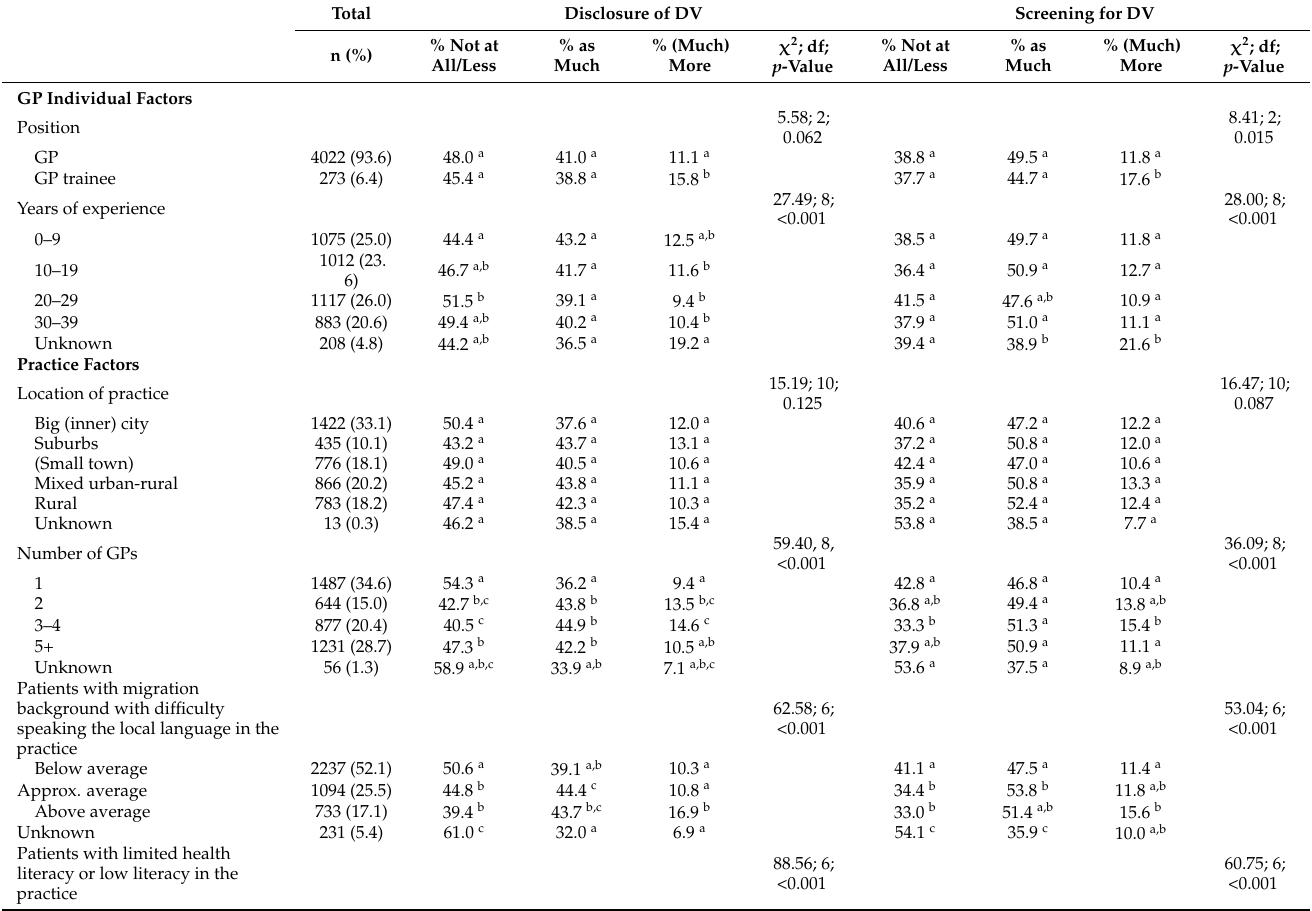
Table 1. Main characteristics of the general practitioners and their practices during the COVID-19 pandemic ( n =